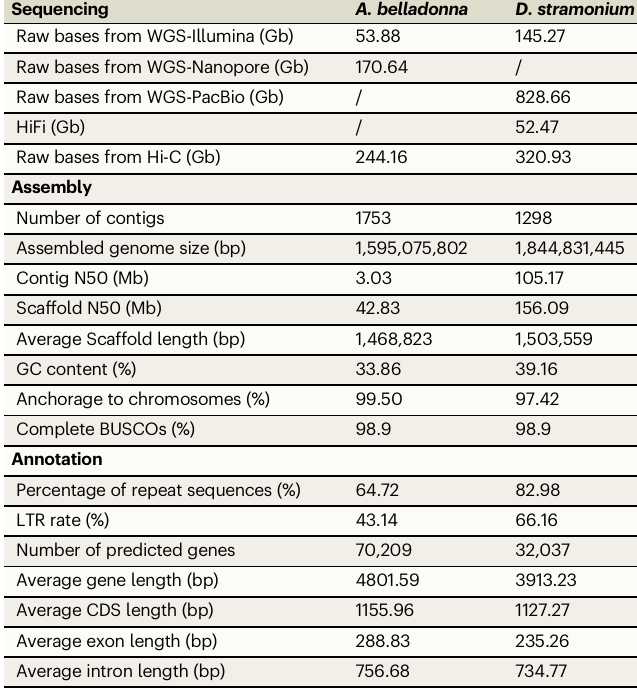
Table 1 | Summary of A . belladonna and D . stramonium